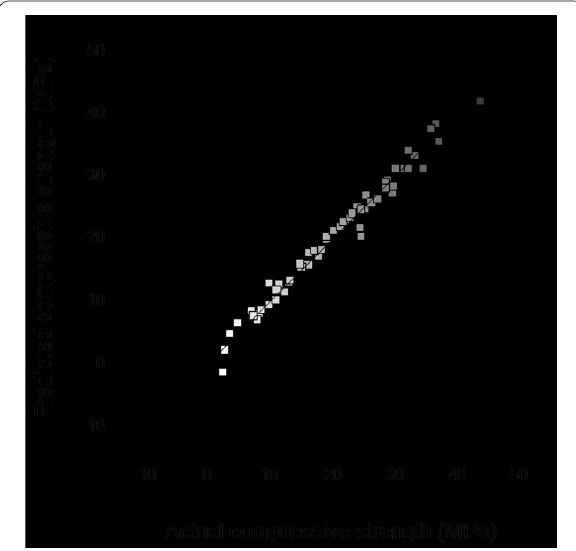
Fig. 10 Plot between predicted versus actual compressive strength